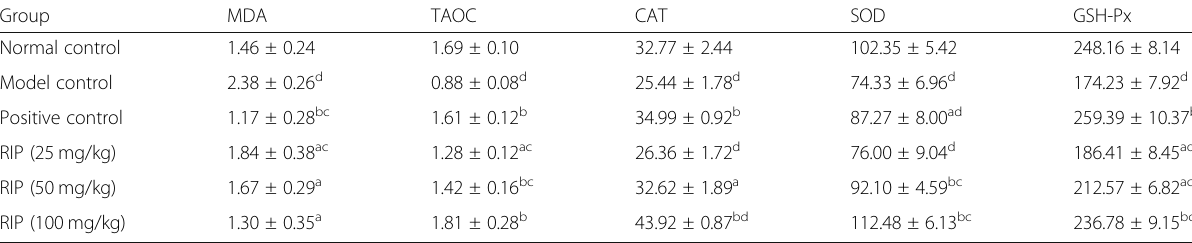
Table 6 Effects of different treatments on the activities of CAT (U/mg protein), SOD (U/mg protein), GSH-Px (U/mg protein) and levels of MDA (nmol/mg protein) and TAOC (U/mg protein) in the kidneys of aging mice Group